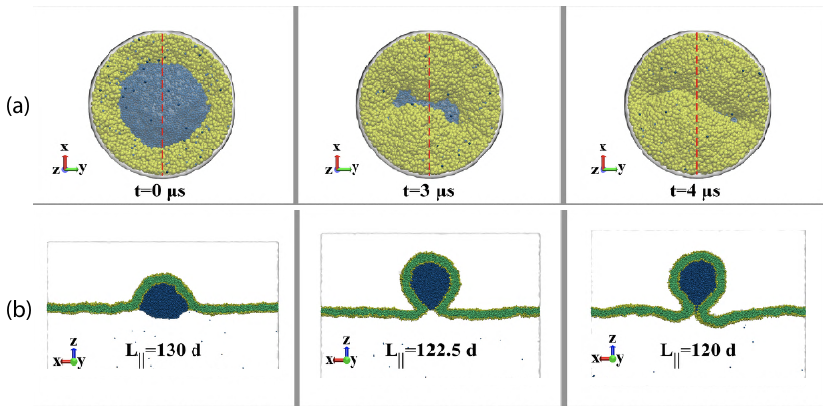
Figure 26. Formation of a non-circular, tight-lipped membrane neck generated by a nanodroplet (dark blue) that adheres to a planar bilayer [29]. This process was induced by a time-dependent reduction of the lateral size L (cid:107) of the simulation box, keeping the box volume fixed: ( a ) Bottom views of circular membrane segments (yellow) around the αβ interface (blue) of the β droplet, separated by the contact line which is circular at time t = 0 µ s, strongly non-circular after t = 3 µ s, and has closed into a tight-lipped shape after t = 4 µ s; and ( b ) Side views of the same membrane-droplet morphology, with perpendicular cross-sections through membrane (green) and droplet (blue) taken along the red dashed lines in panel ( a ). The non-circular shape of the membrane neck is caused by the negative line tension of the contact line and prevents membrane fission. The droplet has a diameter of about 12nm. Same color code as in Figure